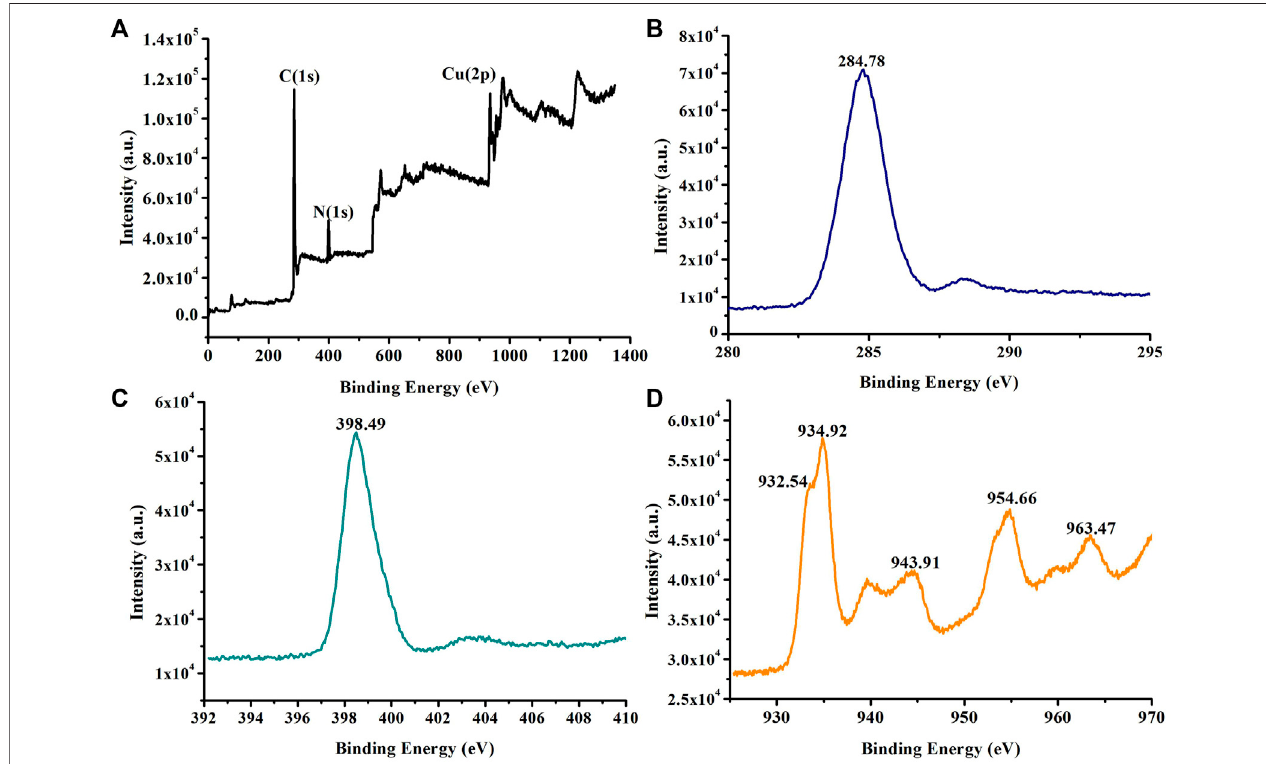
FIGURE 1 | XPS of 1 : (A) survey, (B) C (1 s), (C) N (1 s), and (D) Cu (2p).